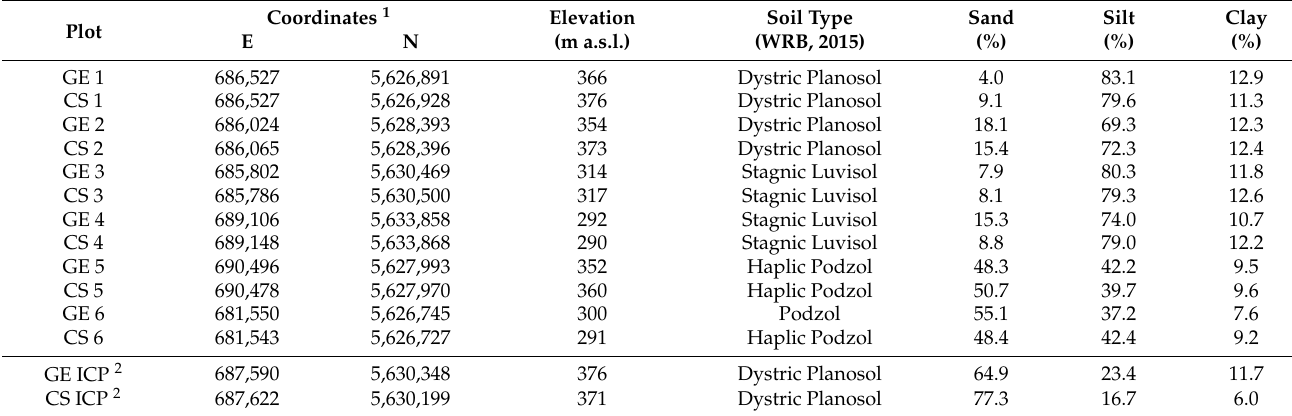
Figure 2. Location of the study area “Hummelshain” in Eastern Thuringia in Central Germany with the locations of the different exploration sites (red points, GE-CS pairs, 1–6) and the monitoring site (blue point, GE/CS ICP). GE: Groups of European beech within stands of Norway spruce and Scots pine (CS). Table 1. Basic characteristics of investigated sites in Thuringia, Germany. GE: Groups of European beech within stands of Norway spruce and Scots pine (CS).